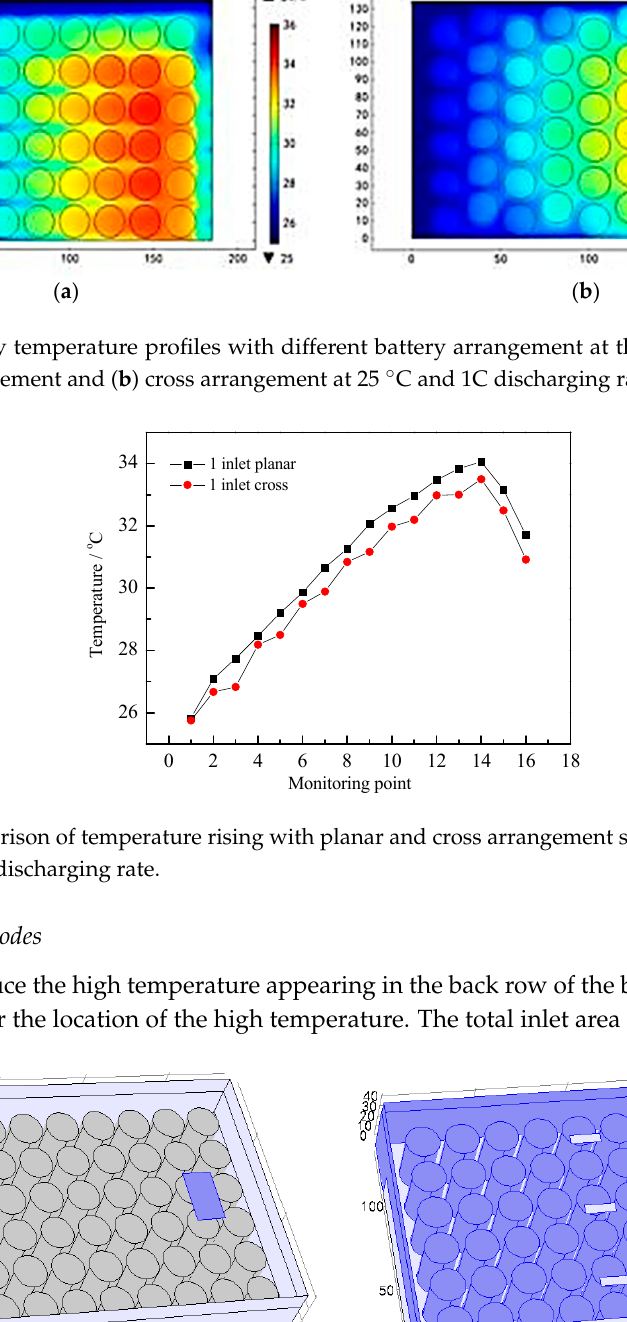
Figure 5. Battery temperature profiles with different battery arrangement at the rate of 1.0 m/s in ( a ) planar arrangement and ( b ) cross arrangement at 25 °C and 1C discharging rate.